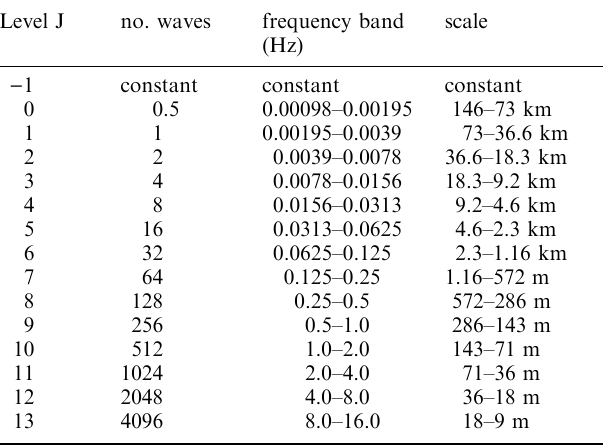
Table 1. Correlation between frequency bands and scales for each wavelet level J. Also shown is the number of wavelets at each